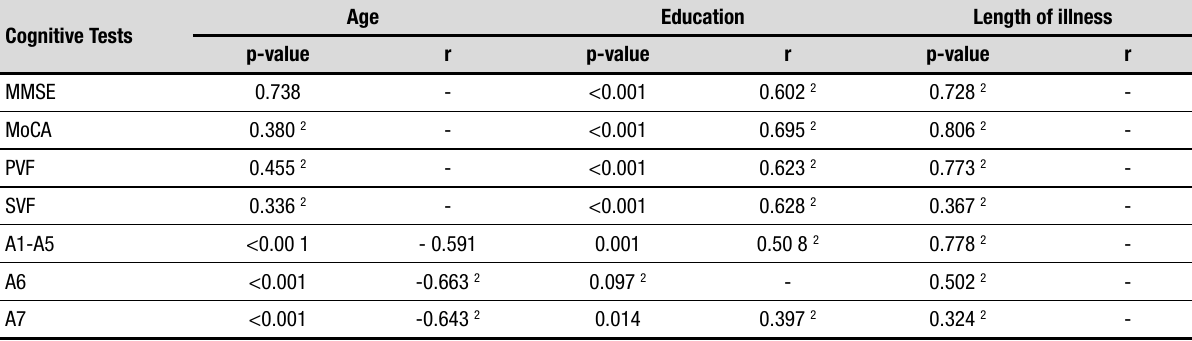
Table 2. Correlations between clinical variables and cognition.